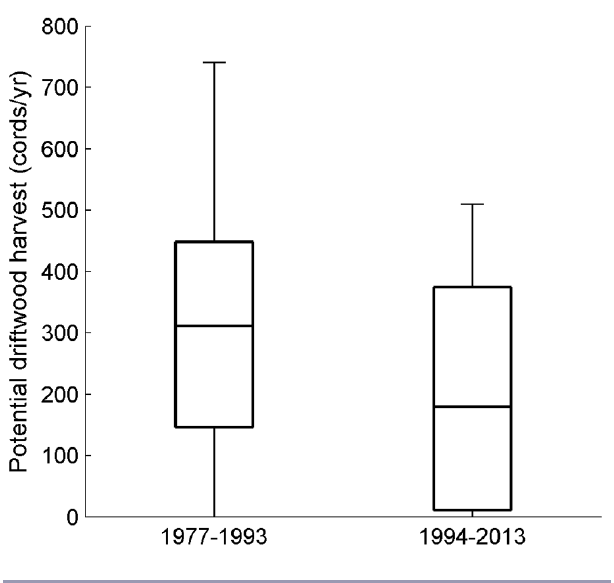
Fig. 3 . The minimum, 25th percentile, median, 75th percentile, and maximum potential driftwood harvest for the early and late phases of the period of record depict small expected harvest volumes in the future.